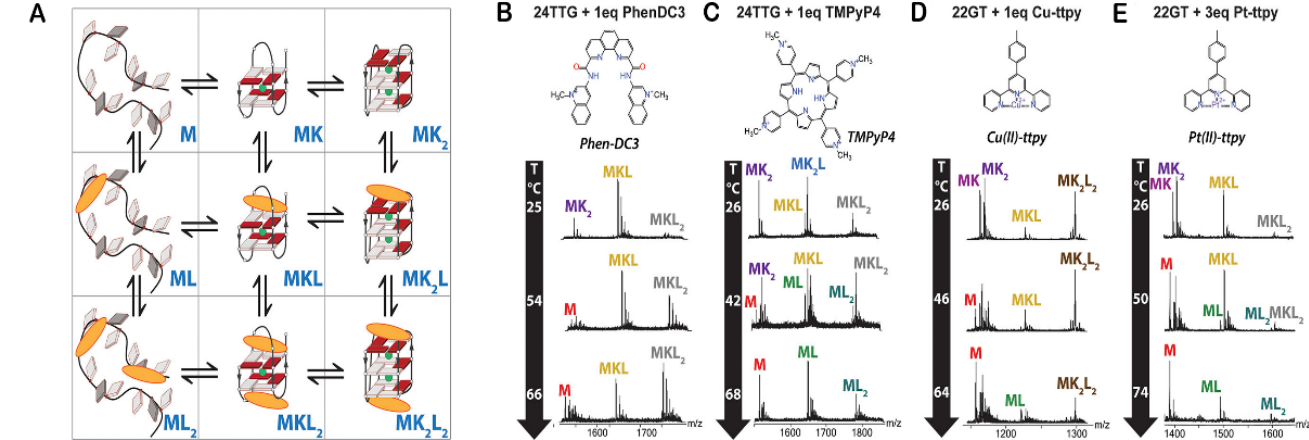
Figure 19. ( A ) Chemical equilibria for ligand binding to a G4 forming sequence. Mass spectra at different temperatures of 10 μ M of human telomeric DNA sequence ( B , C : 24TTG; D , E : 22GT) in the presence of 1 or 3 equivalents of ( B ) Phen-DC3, ( C ) TMPyP4, ( D ) Cu-ttpy, and ( E ) Pt-ttpy. The buffer used was 100 mM TMAA and 1 mM KCl. The volume of oligonucleotide solution was approximately 10 μ L. Reprinted with permission from ref. [191] Copyright 2017 American Chemical Society.